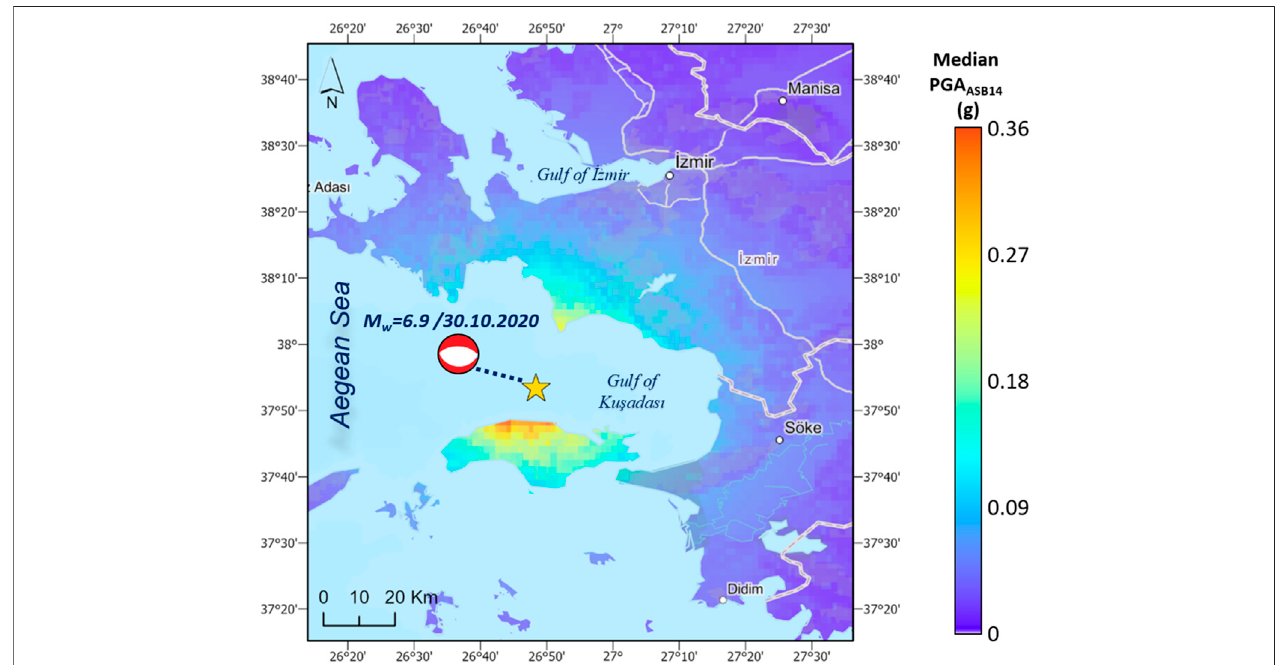
FIGURE 9 | The spatial distribution of estimated median PGA levels according to Akkar et al. (2014).